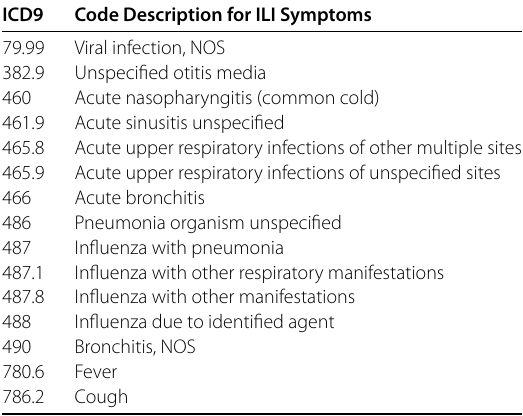
Table 1 The ICD-9 codes used to describe ILI symptoms and their descriptions